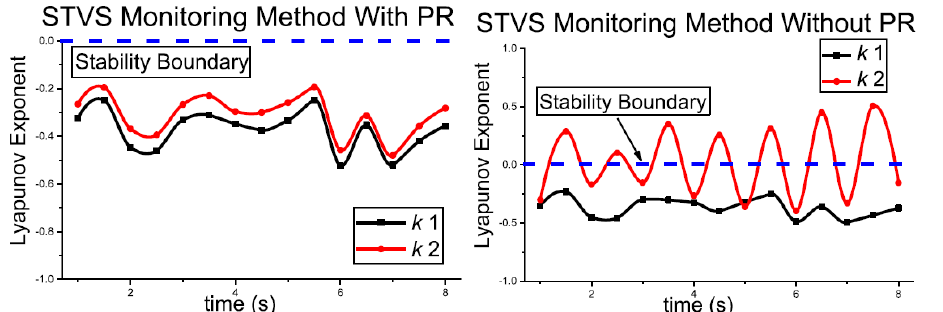
Figure 2. Comparison of LE-based method for cases ( a ) with; ( b ) without phase-rectification designed to smooth out the oscillatory behaviour of the exponent [14]. Copyright: IEEE.